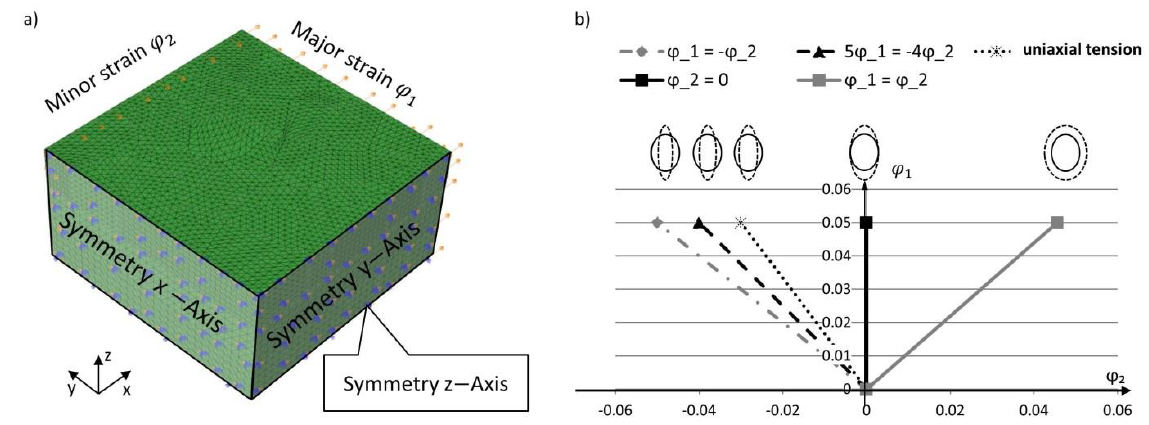
Figure 3. ( a ) Boundary conditions of the numerical model; ( b ) evaluated states of strain. Table 2. Boundary and contact conditions of the model.